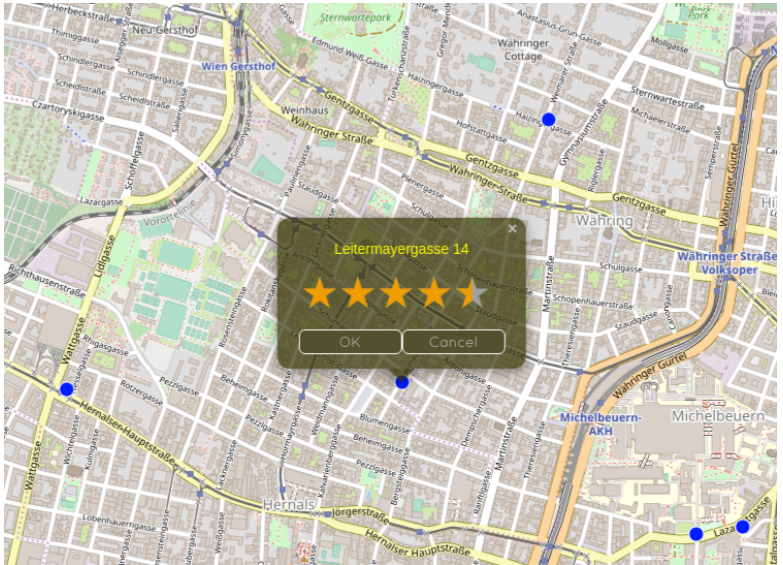
Figure 2. Exemplary evaluation of a location scenario by a user in the COA framework: A potential solution in form of a map with highlighted locations is presented, and the user can than provide suitability values for the highlighted locations in the form of